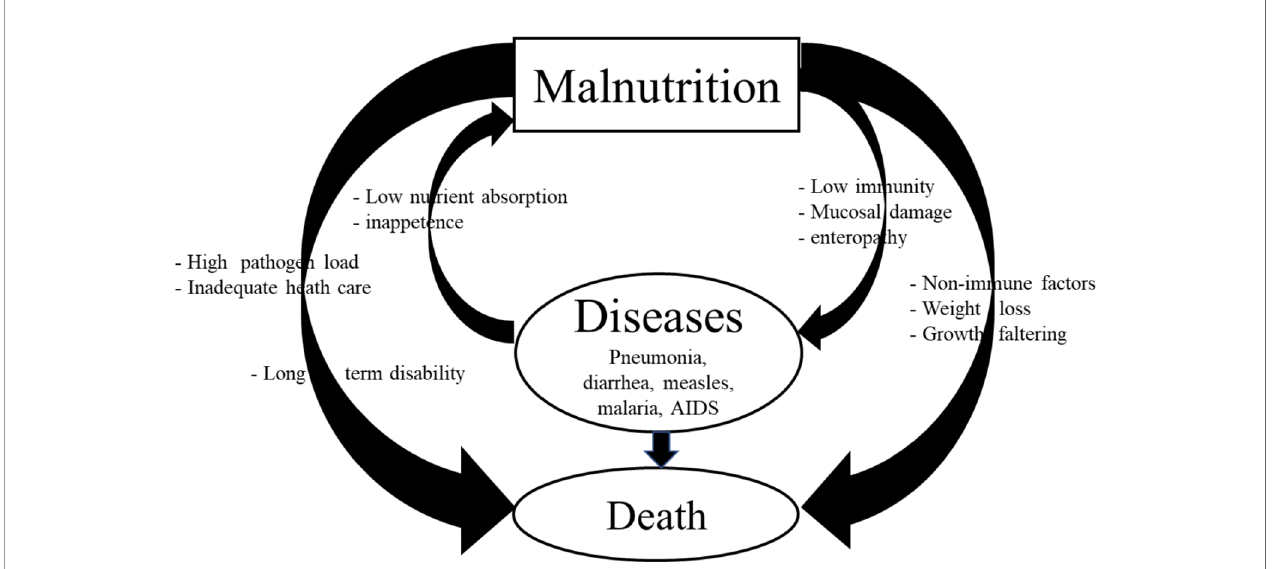
FIGURE 1 | Vicious cycle of malnutrition and infection and its impacts on morbidity, mortality, and long-term